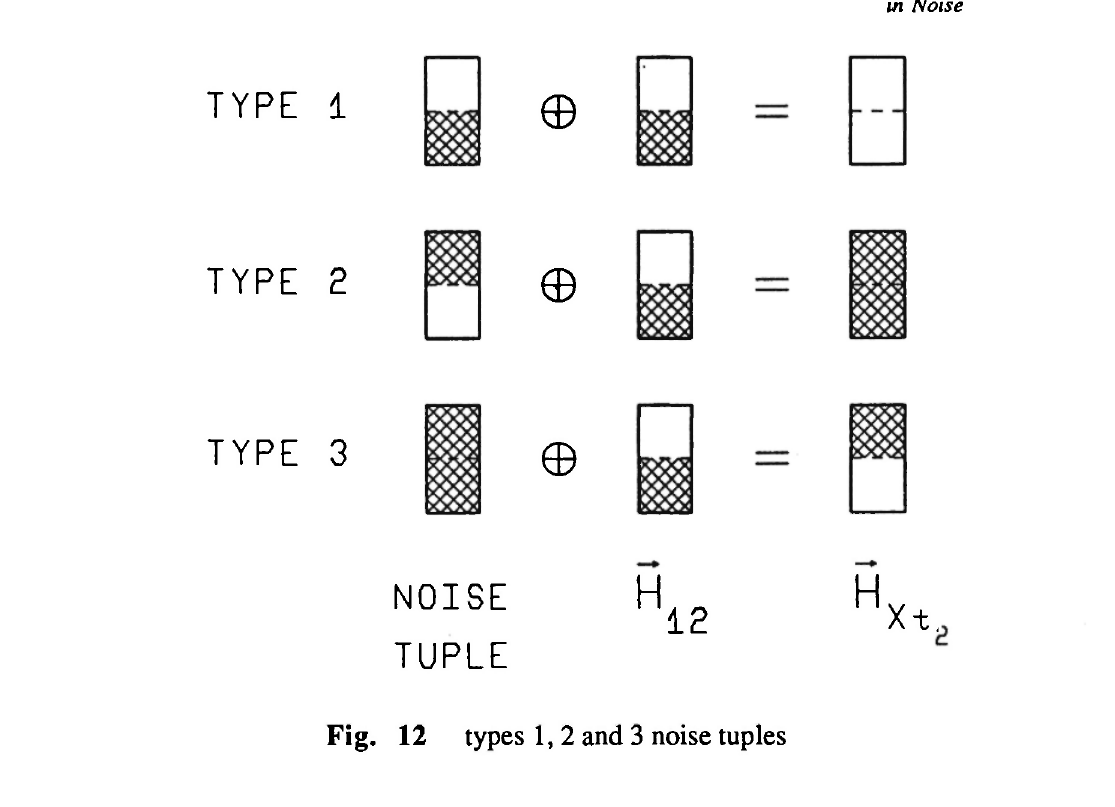
Fig. 12 types 1, 2 and 3 noise